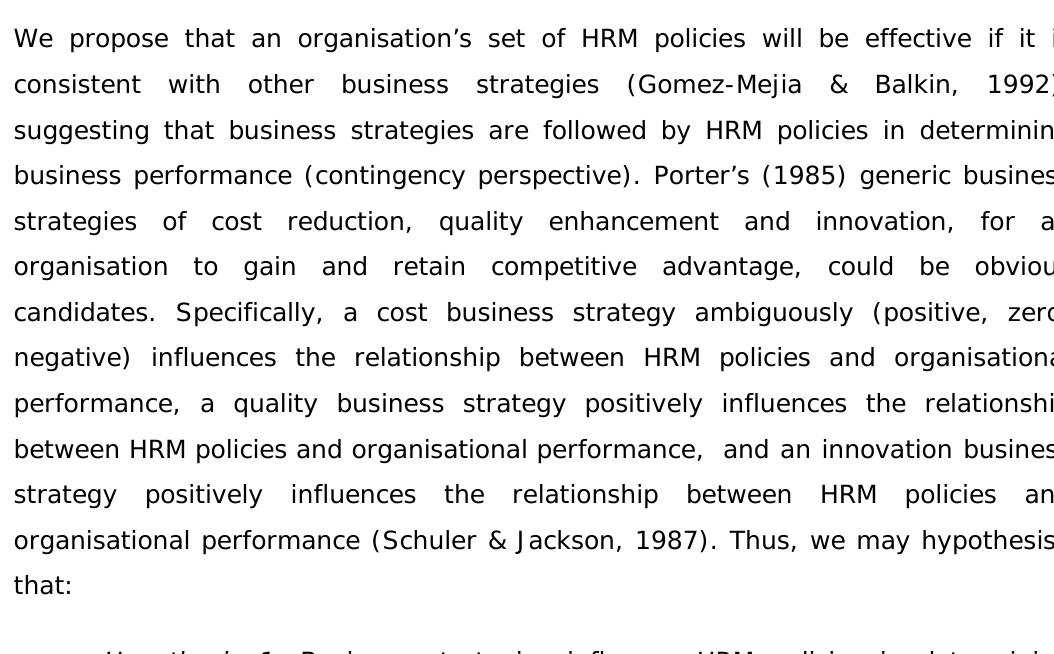
Figure 1. “The operational HRM-performance linkage